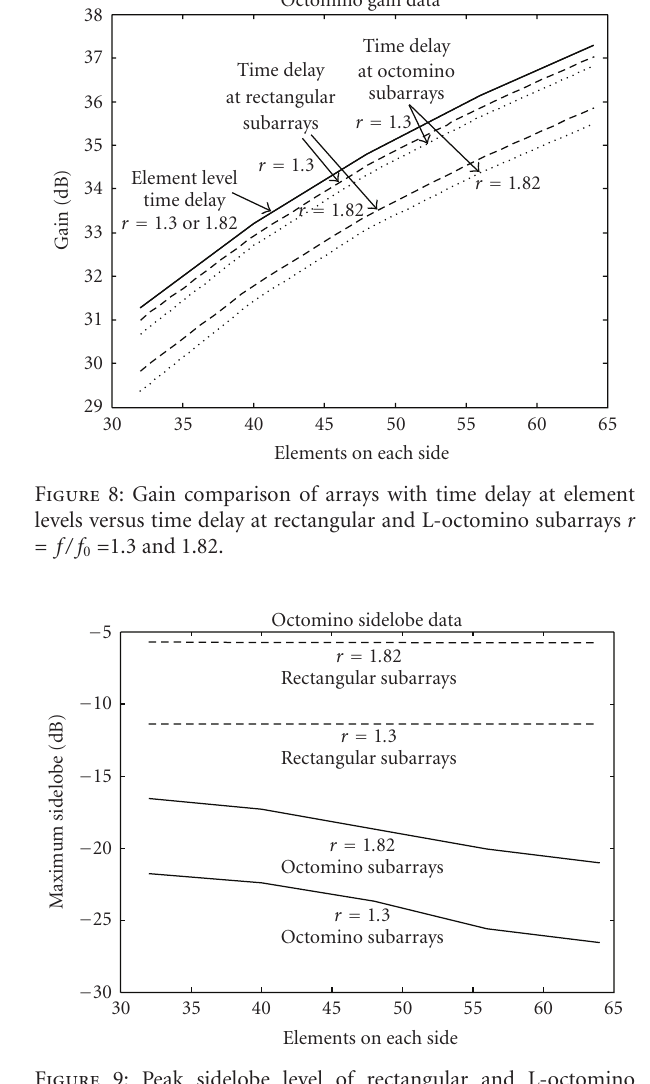
Figure 9: Peak sidelobe level of rectangular and L-octomino subarrays r = f/ f 0 = 1.3 (moderate bandwidth) and r = 1.82 (wide